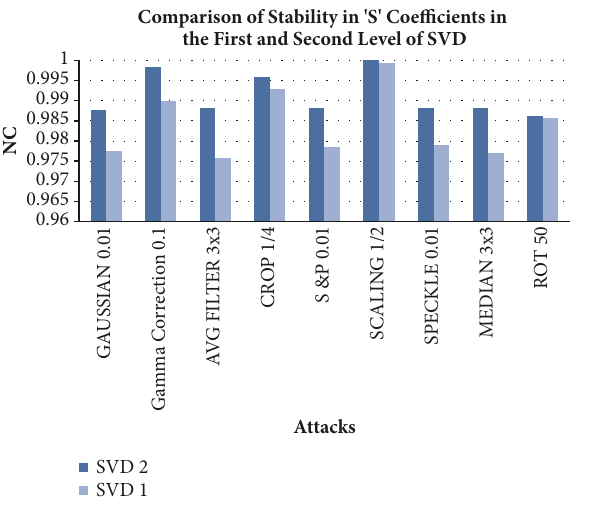
Figure 5: Comparison of stability in “S” coefficients in the first and second level of SVD for 33 images 512 ∗ 512.